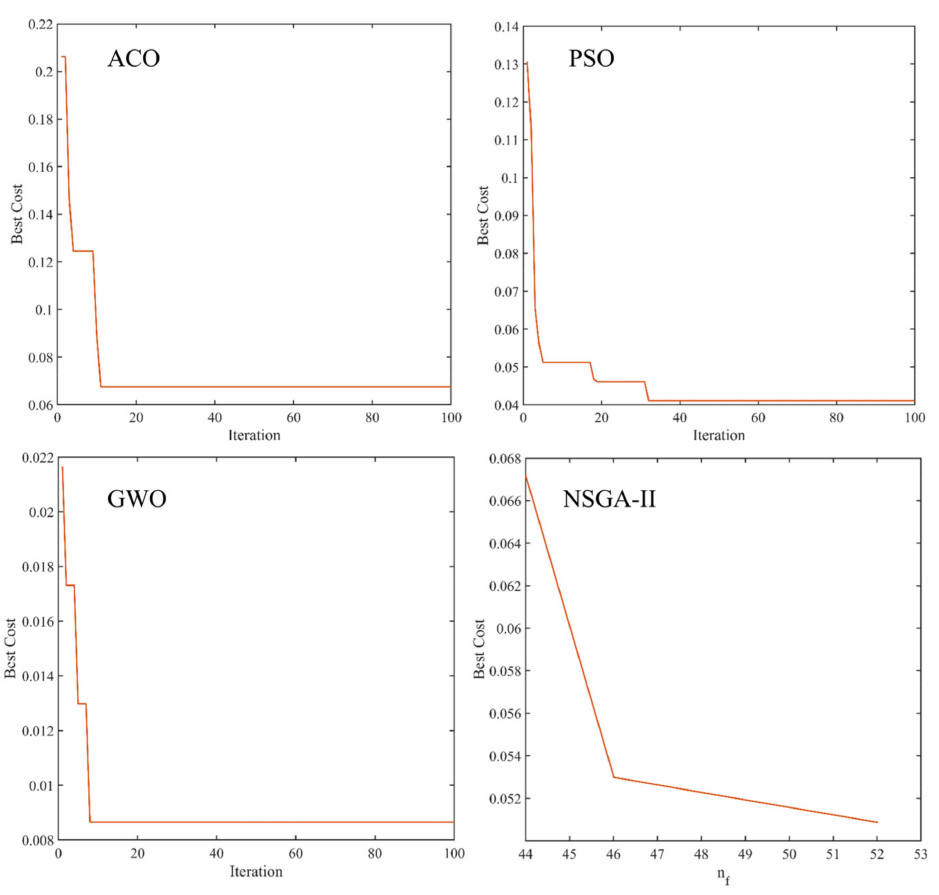
Figure 5. Convergence curves of feature variable selection for different swarm intelligence